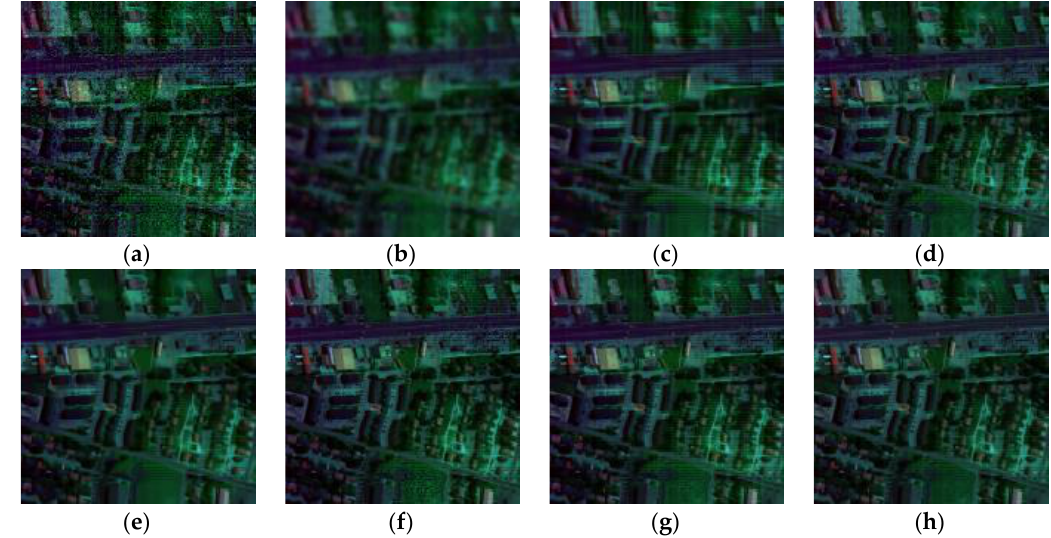
Figure 17. Restored results of Urban image: ( a ) original false-color image (R: 1, G: 104, and B: 135); ( b ) KSVD; ( c ) BM3D; ( d ) ANLM3D; ( e ) BM4D; ( f ) LRMR; ( g ) DDL3+FT; ( h ) Our method.